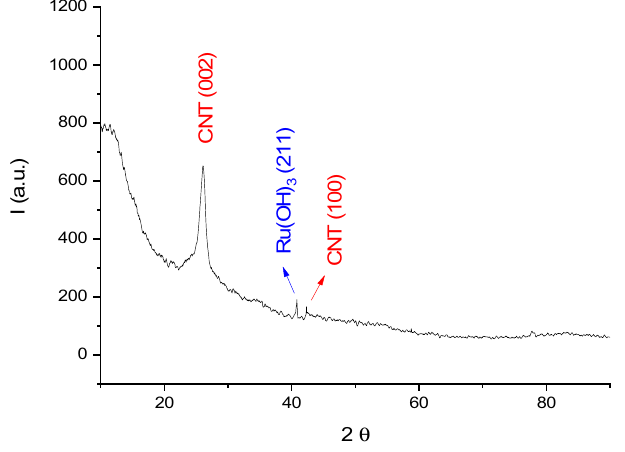
Figure 1. XRD diffraction patterns of MWCNT/Ruthenium hydroxide aerogel between 2θ = 10°–90°